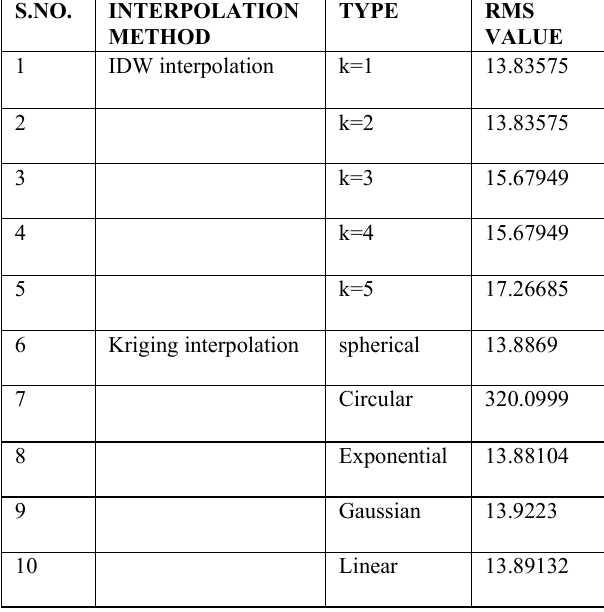
Table 1. Comparison between the RMS value of Kriging and IDW interpolation for different powers.